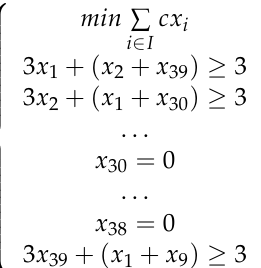
Figure 4. IEEE 39-bus system.